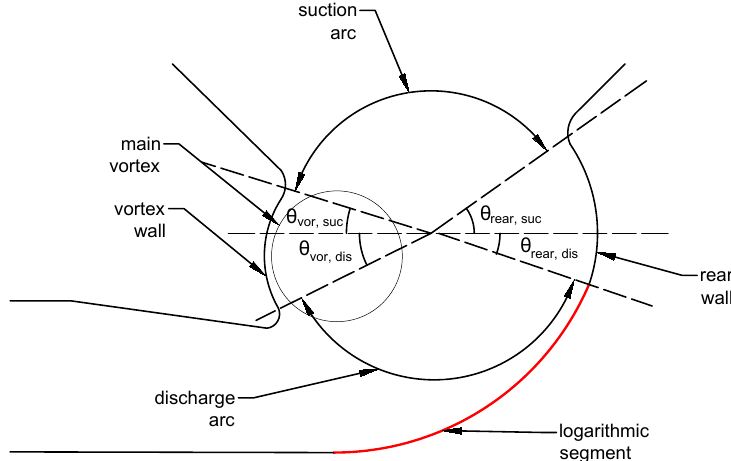
Figure 4. The suction and discharge arcs’ geometrical approximations.